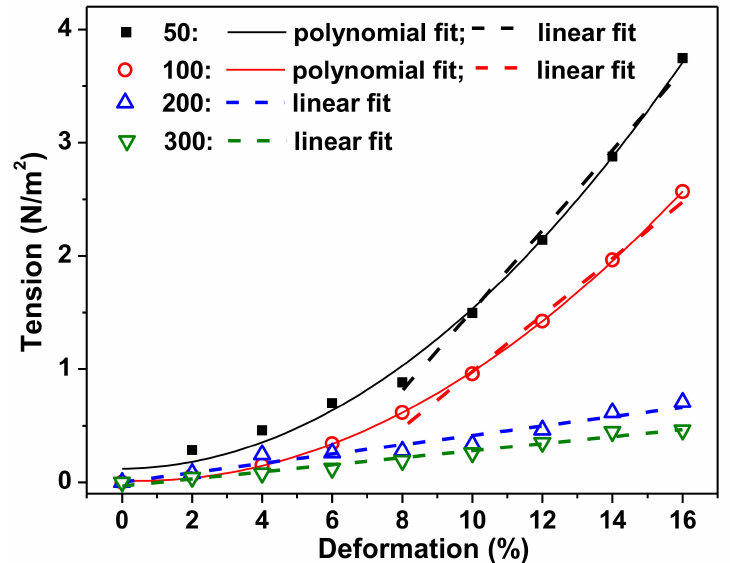
Figure 5. Typical examples of deformation–tension dependencies obtained in PAAm gels with different cross-linking densities of the polymer network. The equations of linear approximation for: